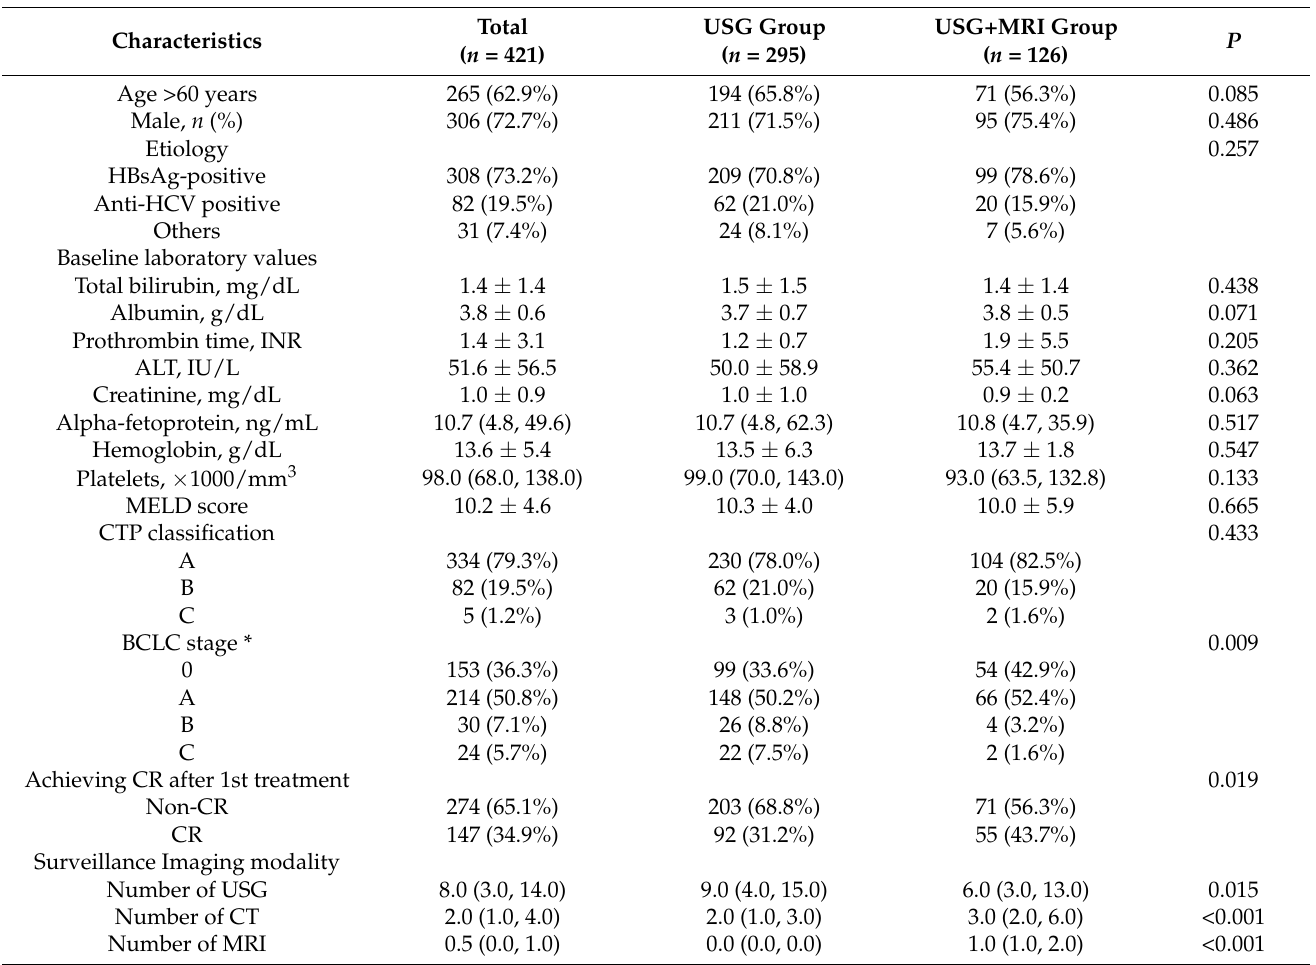
Table 1. Baseline